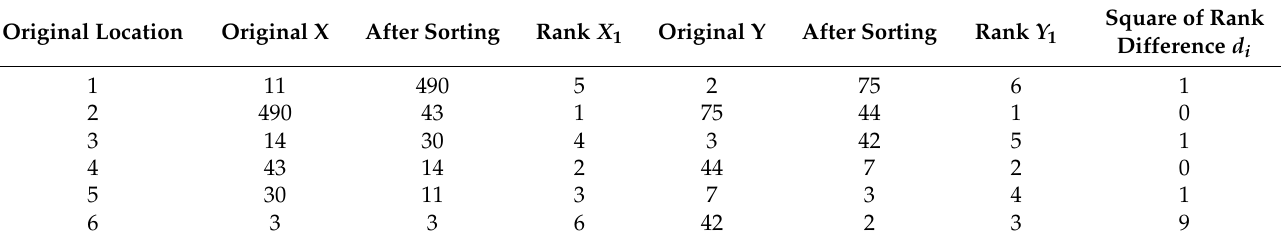
Table 1. A simple example of explaining the meaning of d i